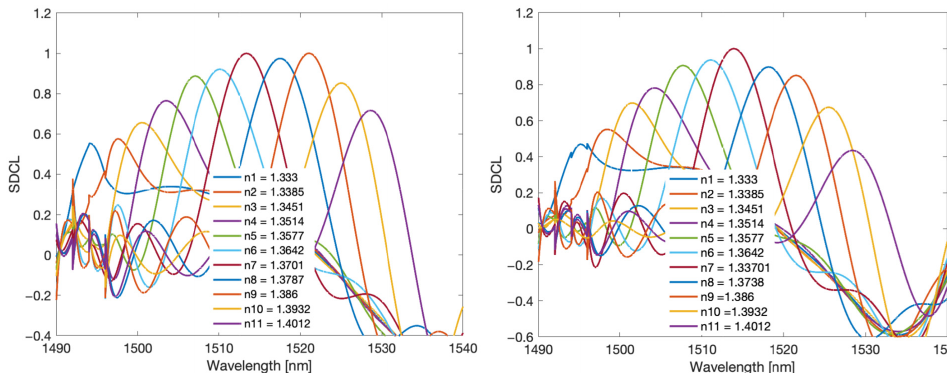
Figure 17. Second derivative of the cumulative spectrum contour for TFBG and DCTFBG.